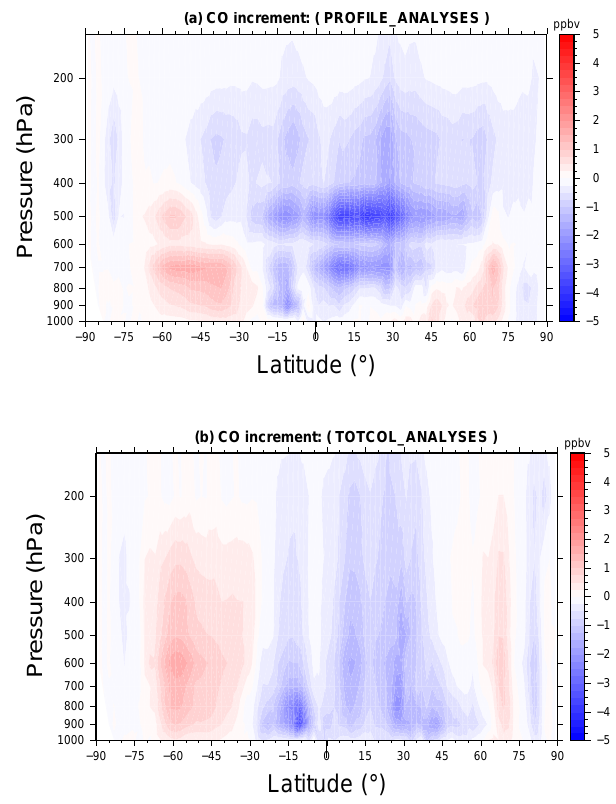
Figure 13. Zonal means of CO increment in ppbv for the month of Fig. 13. Zonal means of CO increment in ppbv for the month of August 2008 as obtained by: (a) : MOPITT PROFILE ANALYSEStaking intoaccount averaging kernels and observation errorcovariance matrices; (b): August 2008 as obtained by MOPITT PROFILE_ANALYSES tak- MOPITTTOTCOL ANALYSES. ing into account averaging kernels and observation error covariance matrices (a) , and by MOPITT TOTCOL_ANALYSES (b)